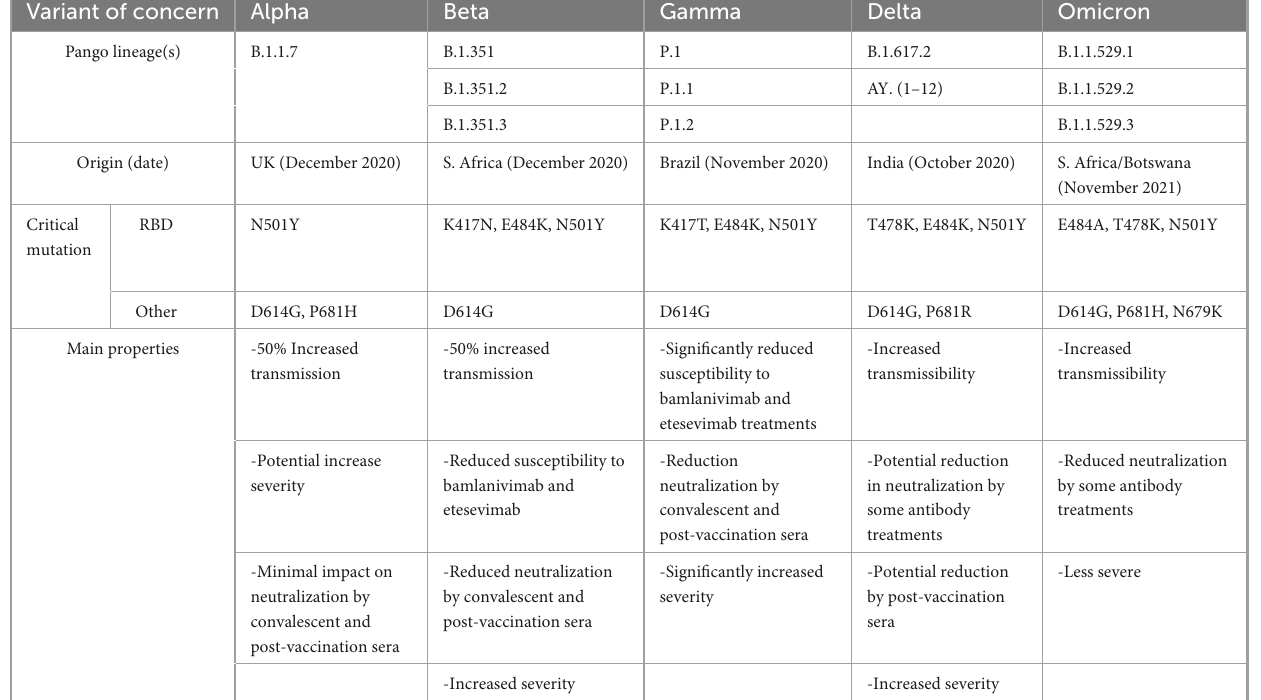
TABLE 1 Main Characteristics of SARS-CoV-2 variants containing the SP mutation sites used in this study. Variant of